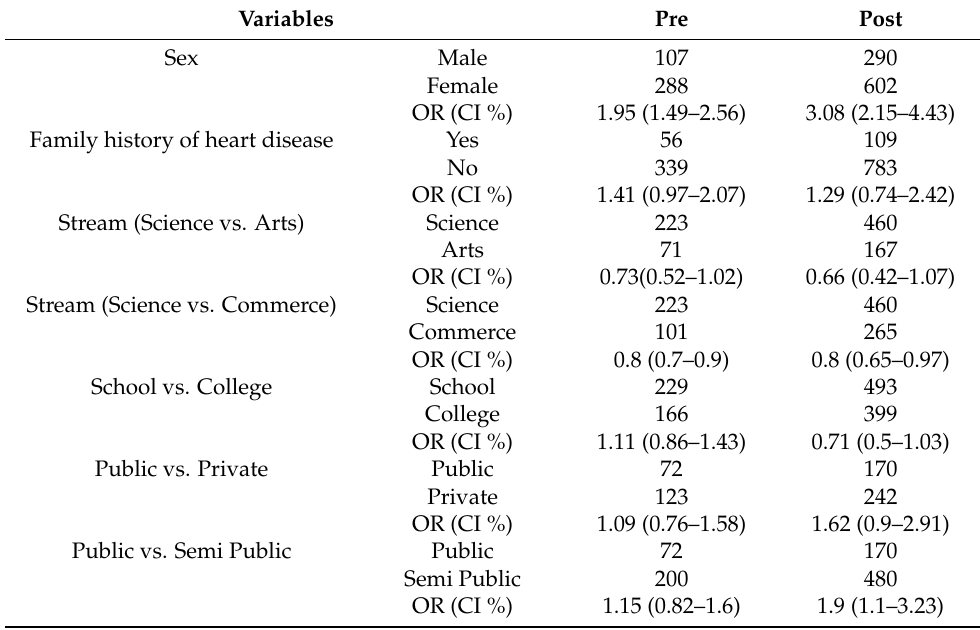
Table 4. Knowledge about symptoms of stroke in different variables.